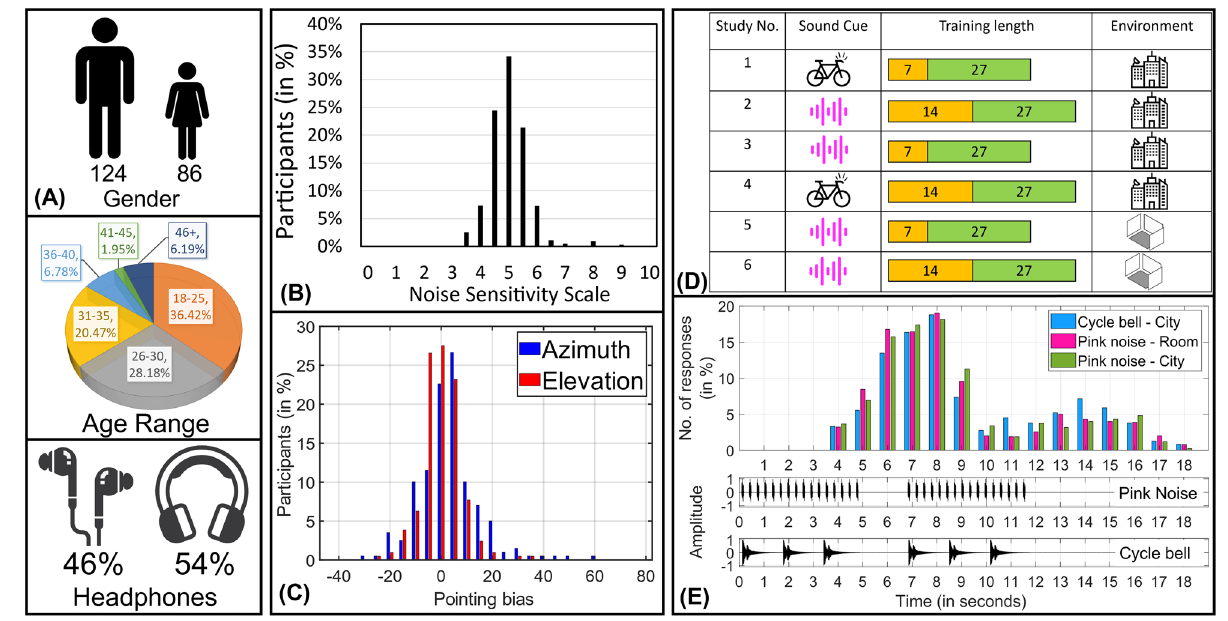
Figure 2. ( A ) (Top) Distribution of participants based on the gender by which they identified themselves. (Center) Distribution of participants based on their age range. (Bottom) Percentage of participants using in-ear and over-ear headphones. ( B ) Distribution of participants on the noise sensitivity scale from 0 to 10. ( C ) To minimize the error due to the fact that participants were new to WebVR, we calculated pointing bias. This is the representation of the number of participants and their pointing bias. ( D ) A graphical representation of all six studies based on their sound cues, training length, and testing environment. ( E ) (Top) Distribution of the frequency of responses for each second from 0 to 18 s. (Bottom) Representation of the sound cue spectra for pink noise and the cycle bell on the timescale from 0 to 18 s. ( A ) Includes parts purchased from